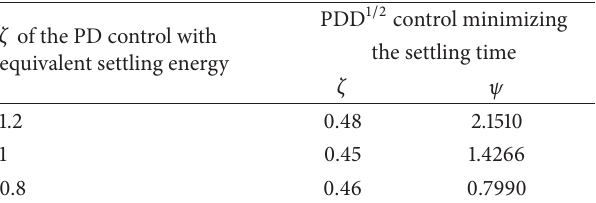
Table 4: 𝜁 - 𝜓 combinations minimizing the dimensionless settling time with dimensionless settling energy equivalent to the pure PD.